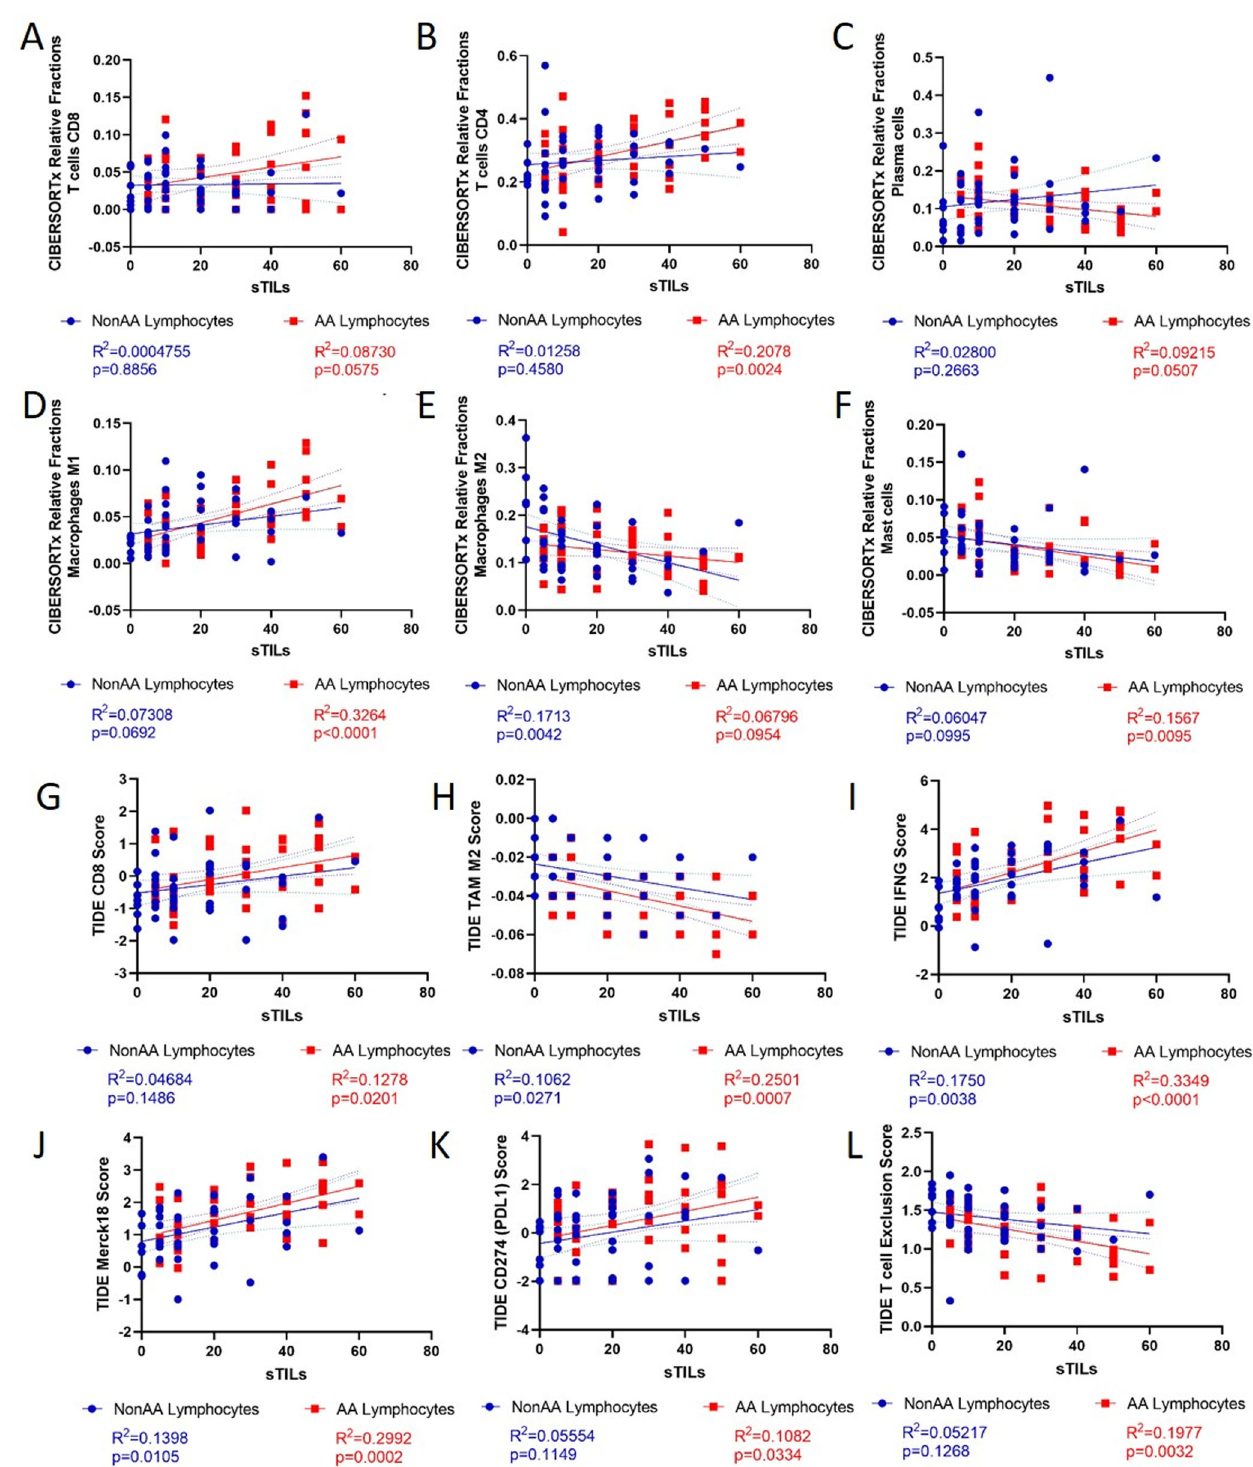
Fig. 5 Correlations between histological stromal TILs (sTILs) and key immune signatures in TNBC in Non-African American (NonAA) and African American (AA) patients. A – F Deconvoluted CIBERSORTx immune cell fractions or G – L TIDE signature scores. Blue = NonAA. Red = AA. p -values from linear